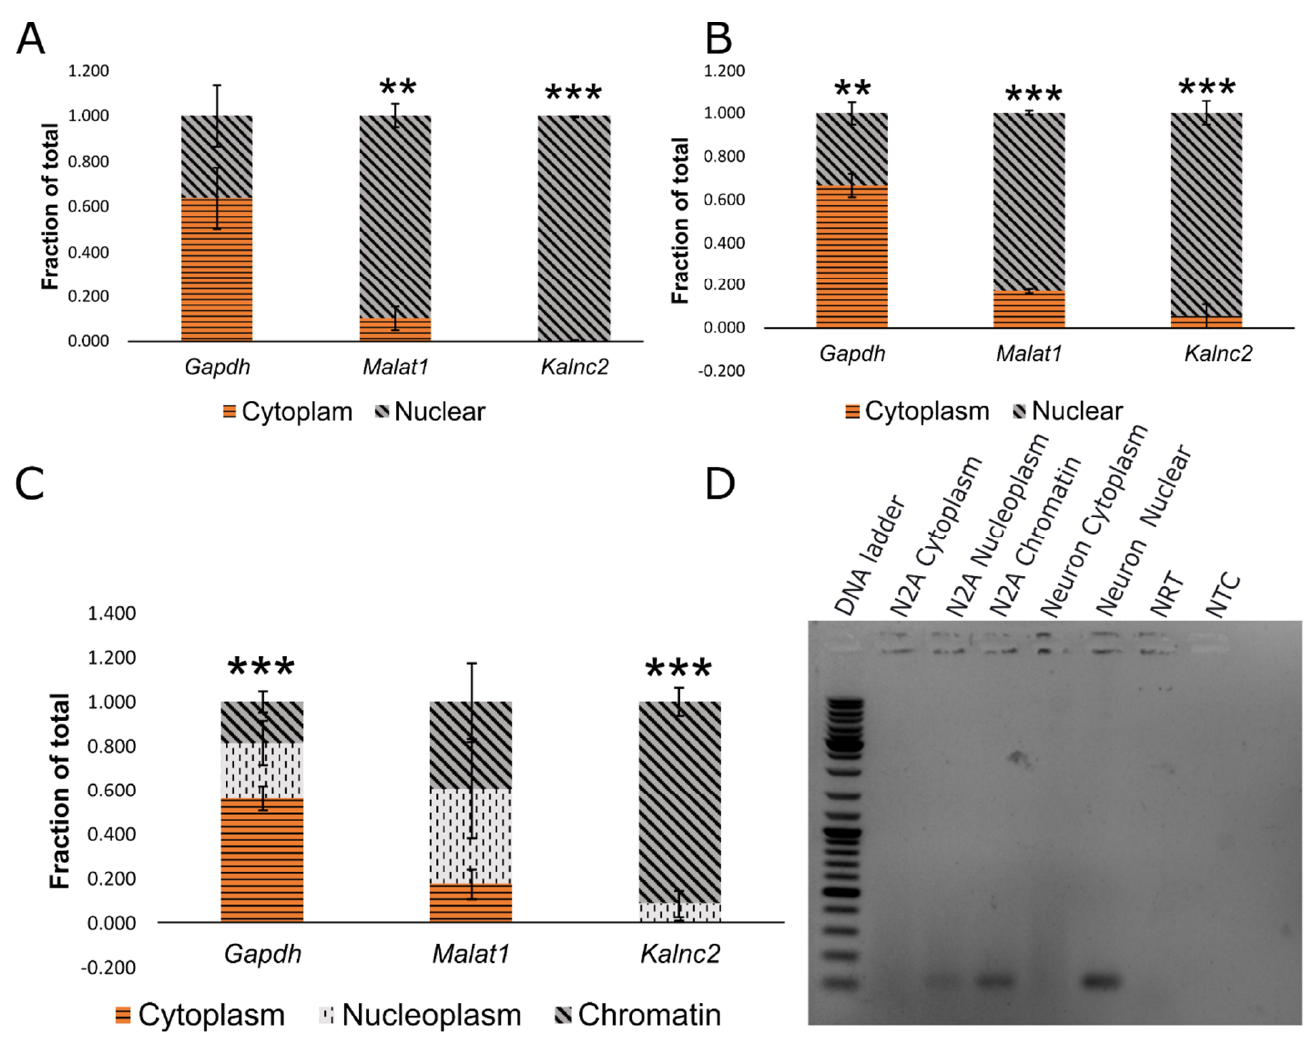
Figure 3. Kalnc2 is enriched in the nuclear fraction. ( A – C ) Kalnc2 expression was measured along with Gapdh (a cytoplasmic marker) and Malat1 (a nuclear marker) in cellular fractions at ( A ) DIV0 (days in vitro culture), ( B ) DIV15 primary cortical neurons, and ( C ) N2A cells by qRT-PCR. ( D ) Endpoint PCR of Kalnc2 in cellular fractions of N2A (Neuro2A) cells and primary cortical neurons. NRT (No reverse transcriptase control), NTC (No template control), and DIV (Days of in vitro culture). (Data are shown as mean ± SD; N = 3 biological replicates; n = 3 technical replicates; t -test, ** p < 0.01; *** p < 0.001).